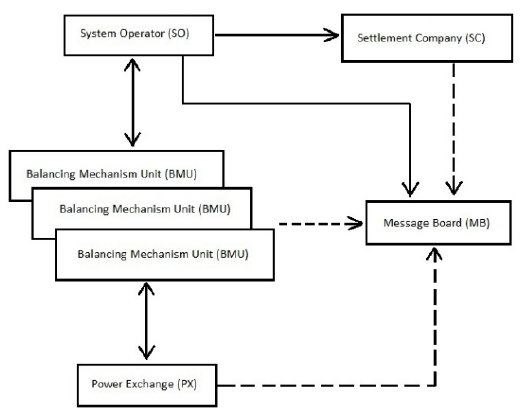
Figure 3. Agents interacting in the short term electricity market. The balancing mechanism units (BMU) could range from big generating units to aggregated demand units. Energies 2016 , 9 , 101